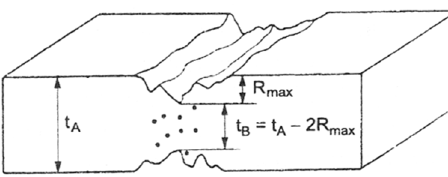
Figure 2. Model of inhomogeneity of the steel sheets (R max —max. value of roughness; t A —initial sheet thickness; t B —thickness after local deformation) [3].